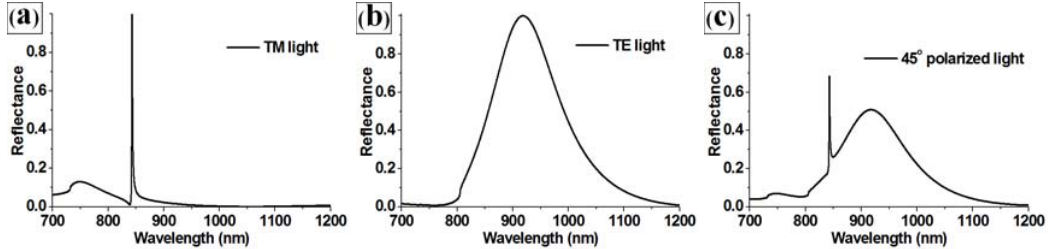
Figure 2. Comparison of the reflection peak spectra of the PC structure ( P = 550 nm, = 0.3, and h = 0.2) for ( a ) TM, ( b ) TE, and ( c ) 45-degree polarized light D = 0.5, h 0 1